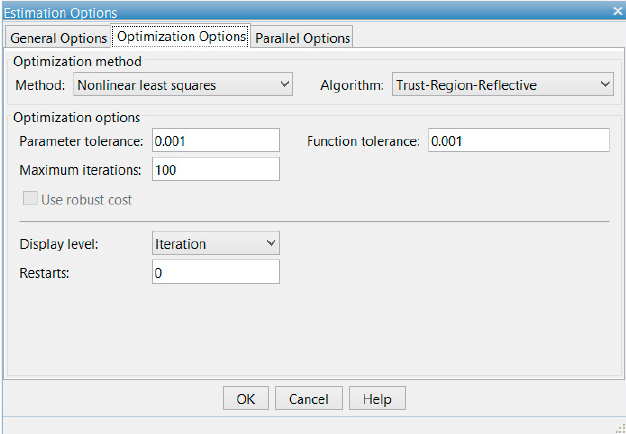
Figure 8. The optimization option user interface for parameter estimation.